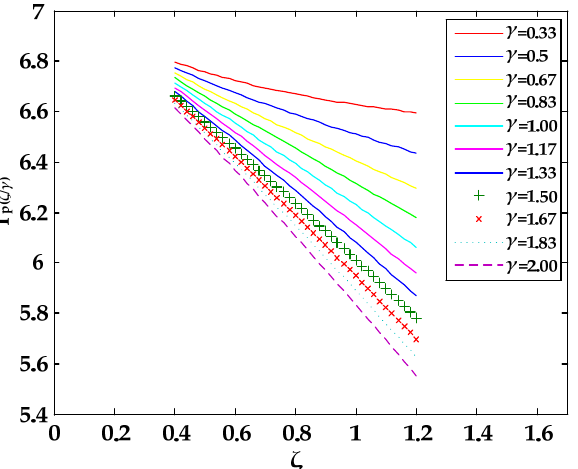
Figure 16. Fitting curve of the periodic equation of the first pulse of the bubble.